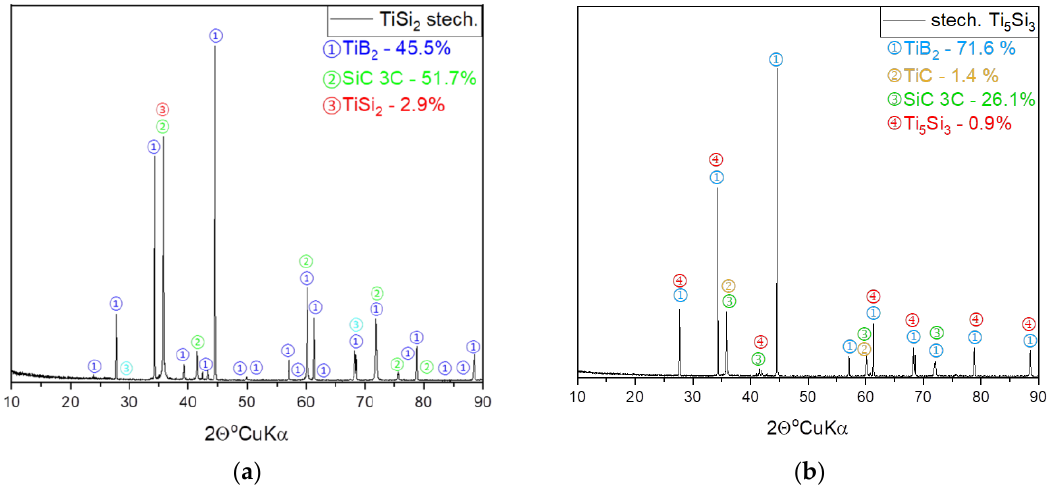
* Additive residue after sintering 2.9% TiSi 2 , 0.9% Ti 5 Si 3 and 1.4% TiC in the stochiometric compo- site with Ti 5 Si 3 .